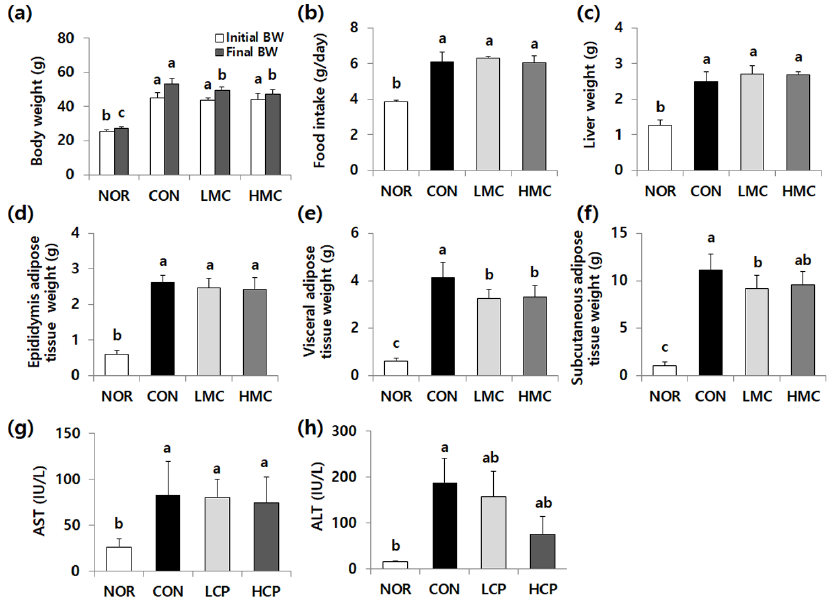
Figure 1. Effects of two skate skin-derived collagen peptides with different molecular weights on body weight ( a ), food intake ( b ), organ weight ( c – f ), and aminotransferase activity ( g , h ). Data are mean ± standard deviation (SD) ( n = 10 per group). Experimental groups were divided into four groups; m/m mice were orally administered water as a vehicle (NOR group) whereas db/db mice were orally administered water (control group, CON), LCP (LCP group), or HCP (HCP group) at a dose of 200 mg·kg bw −1 ·day −1 for 8 weeks. a–c Different letters mean significant differences to one-way analysis of variance (ANOVA), followed by Duncan’s multiple-range test at p < 0.05.